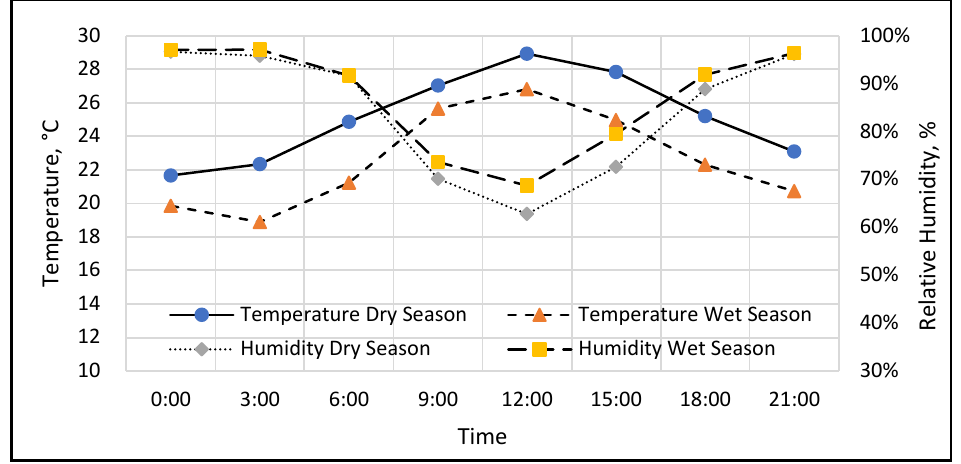
Figure 2. Typical temperature and humidity profiles in dry and wet Season in Pangalengan Area [29] .